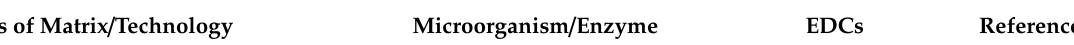
Table 3. Immobilization matrix / technologies in EDCs